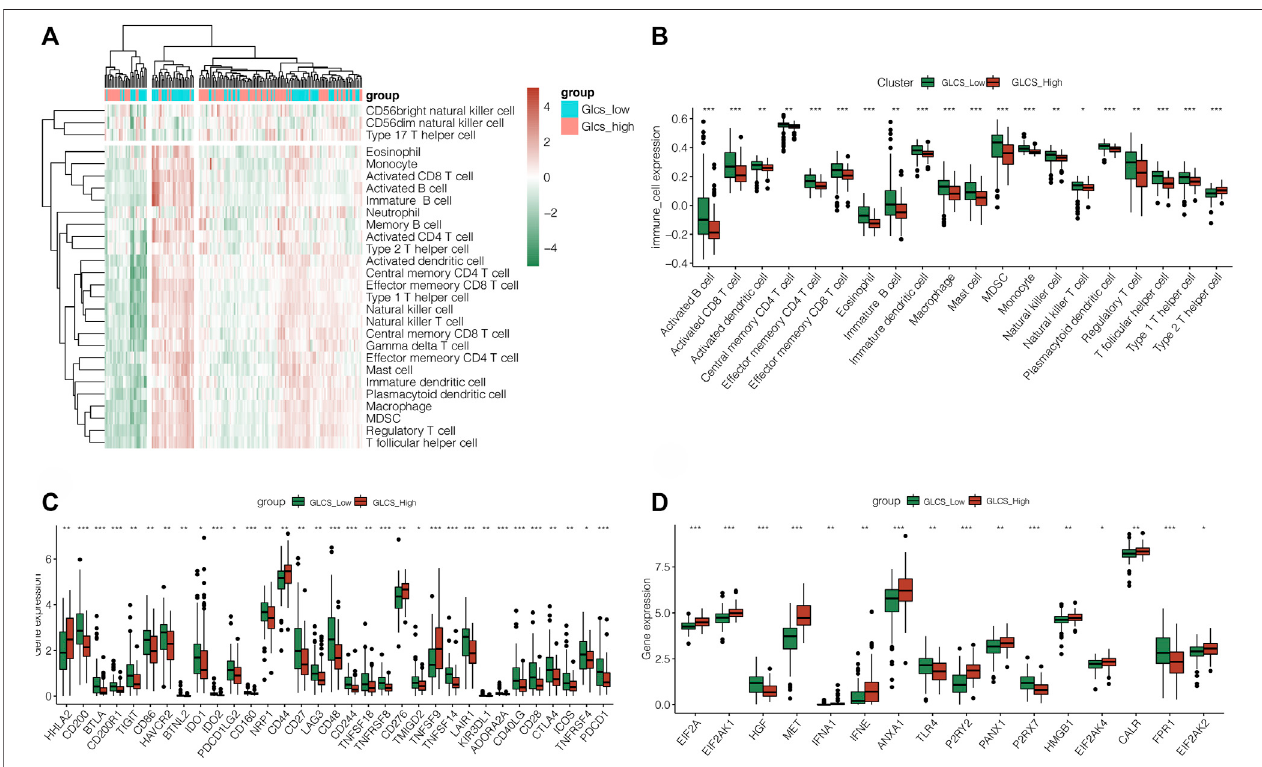
FIGURE 6 | Exploration of the relation between GLCS and immune in fi ltration. (A) Immune landscape of PC patients. (B) Difference in immune in fi ltration levels between the two groups in the form of a box plot. (C) Differences in the immune checkpoint gene expression between high-risk and low-risk groups. (D) Differences in the expression of immunogenic cell death genes between high-risk and low-risk groups (* p < 0.05, ** p < 0.01, and *** p < 0.001).